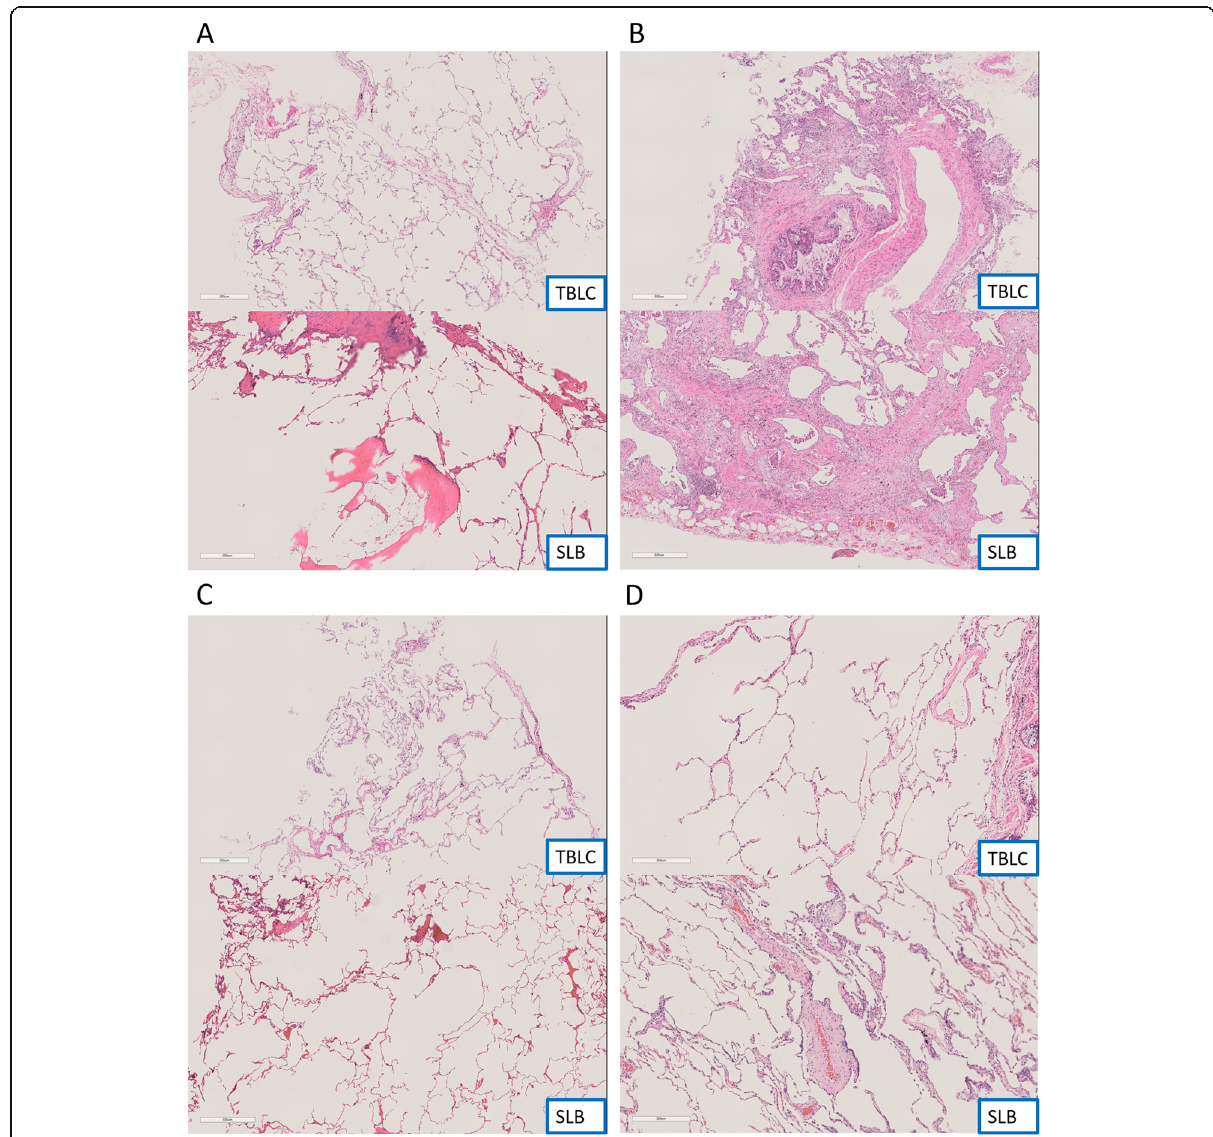
Fig. 1 a : TBLC specimen shows mild invasion of inflammatory cells in the alveolar septum. SLB specimen reveals bone formation with myeloid tissue along the interstitium. b : Dense fibrosis and fibroblastic foci found in TBLC specimen were also seen in SLB specimen. c : Cellular IP shown in TBLC specimen were less represented in SLB specimen. d : Organizing pneumonia and PBM seen in SLB specimen were not noted in TBLC